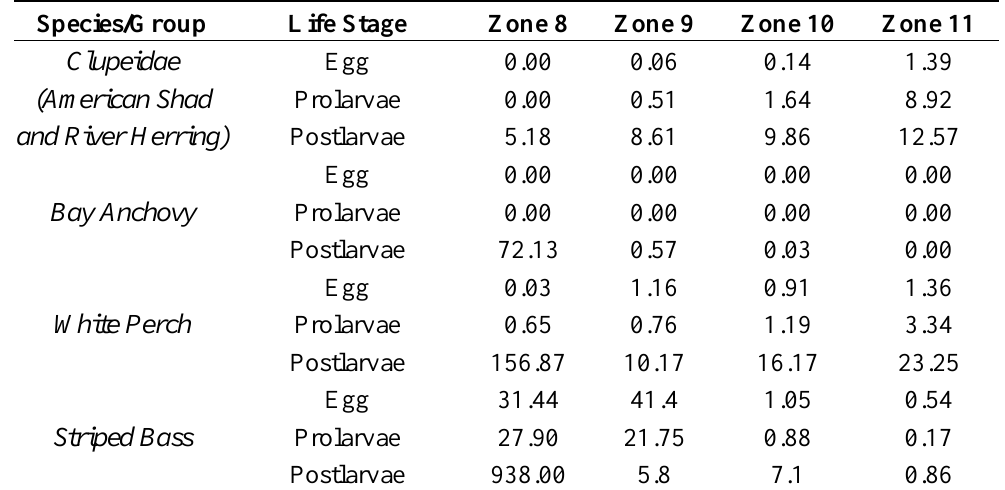
Table 1. Entrainable IP by PSEG zone (number of organisms per 1000 ft 3 of water).